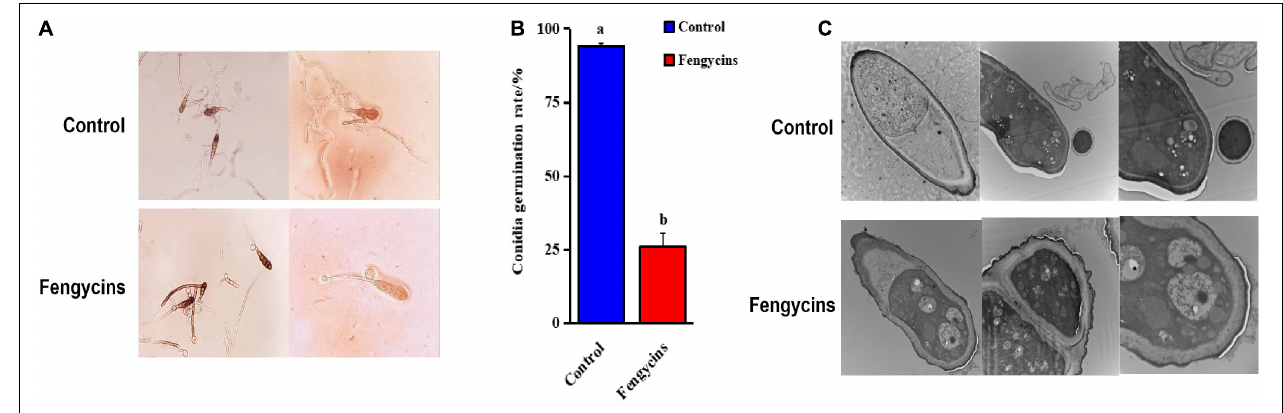
FIGURE 7 | Effects of fengycins on conidial germination and structure. (A,B) Reduction in the conidial germination of A. solani after treatment with fengycins. (C) Transmission electron micrographs of A. solani co-cultured with fengycins. Data are presented as means of three replicates ± SDs, and error bars represent the SDs for three replicates. Means with different letters are significantly different ( p < 0.05).